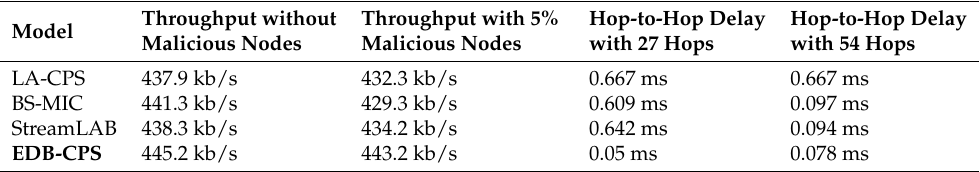
Table 3. Comparative analysis of the proposed EDB-CPS and the contending models—IA-CPS, BS-MIC, and